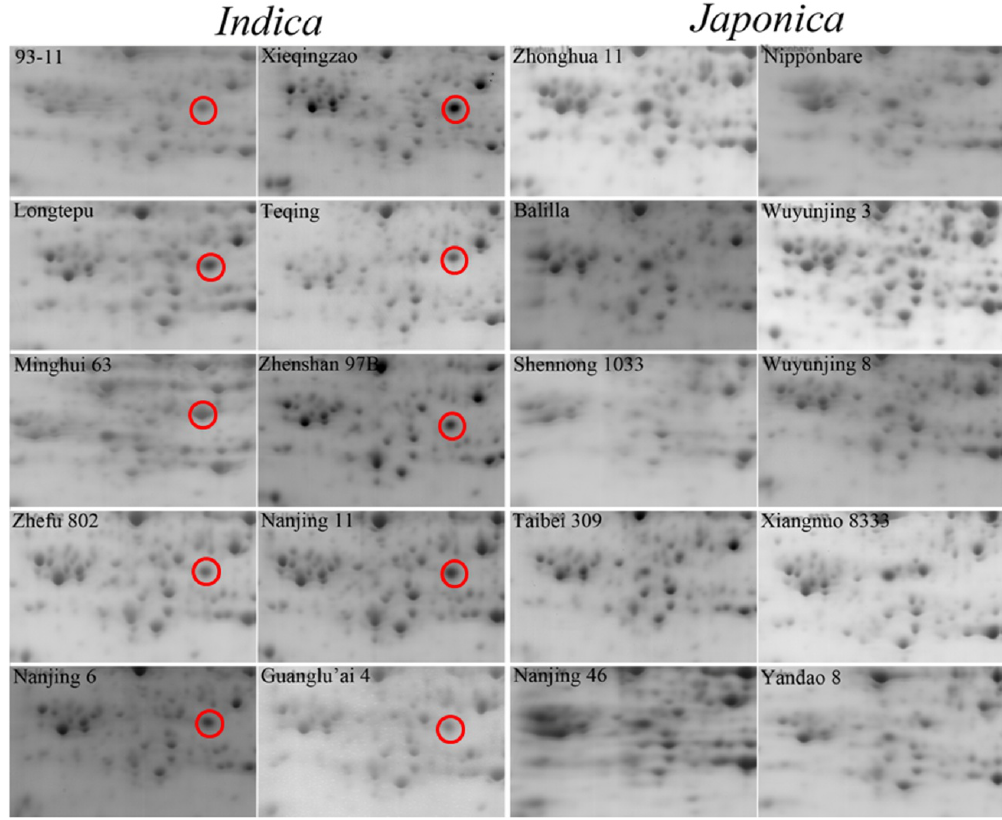
Figure 2. Part of 2-DE of proteins from 10 indica and 10 japonica varieties yellow seedling. The red circles indicate the unique protein (spot No. 1) detected only in indica rice varieties.